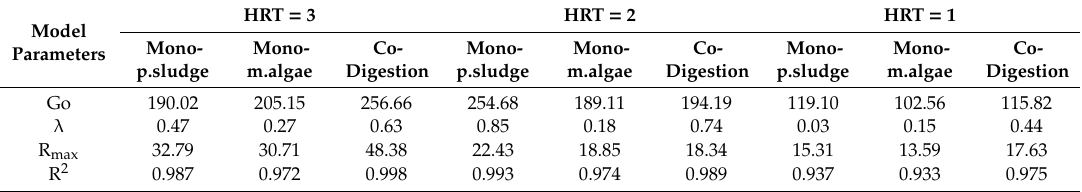
Table 4. Kinetic model parameters (after anaerobic pretreatment